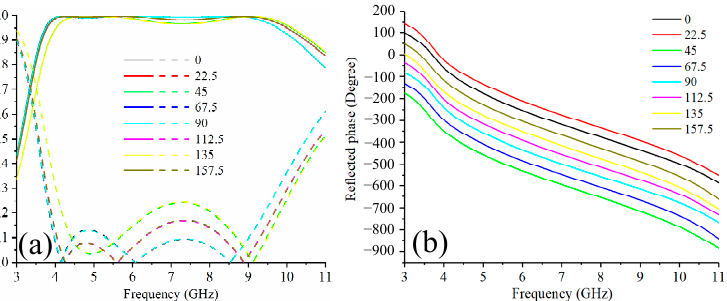
Figure 2. The simulation results of the proposed PB unit cell under different rotation angles: ( a ) Reflection amplitude. ( b ) Reflection phase.